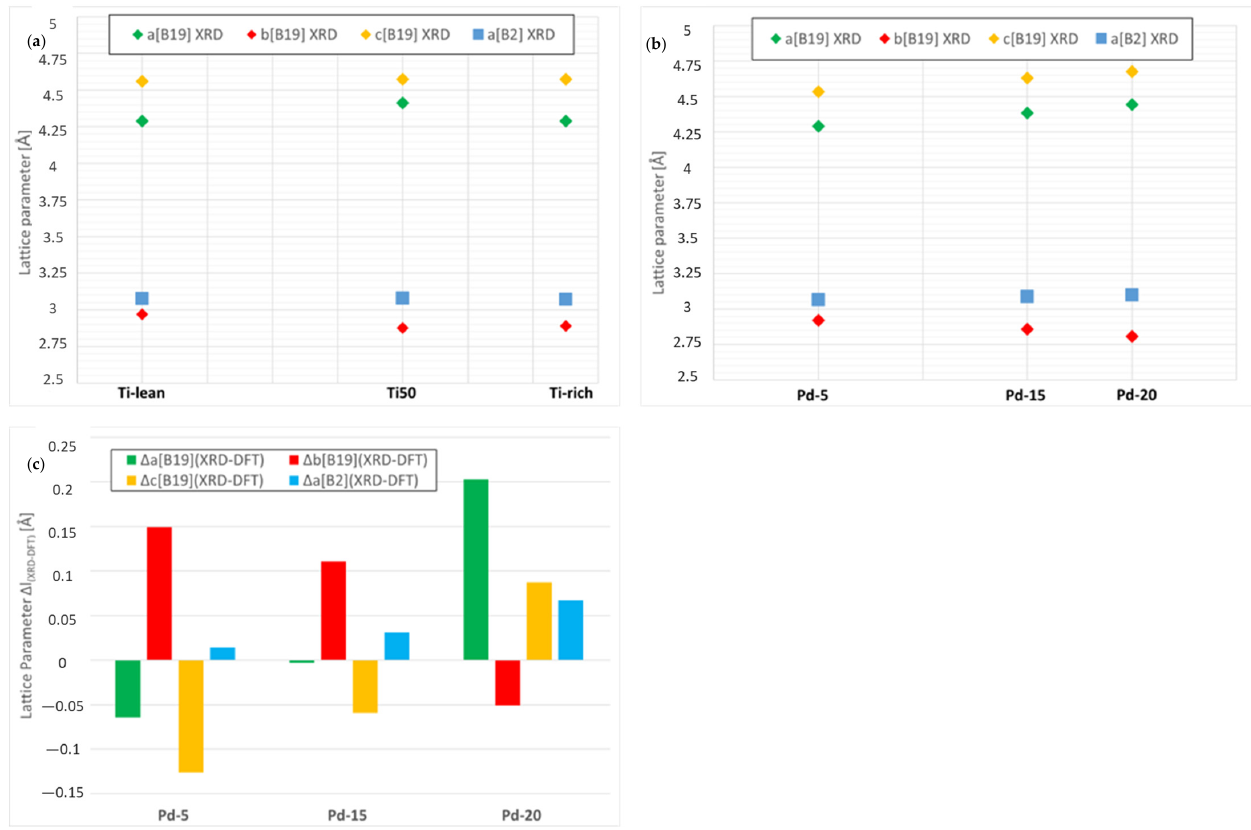
Figure 9. XRD Lattice parameters measured by XRD for homogenized alloys of: ( a ) group A and ( b ) group B; ( c ) the difference between the lattice parameters measured by XRD and calculated by DFT for alloys of group B.